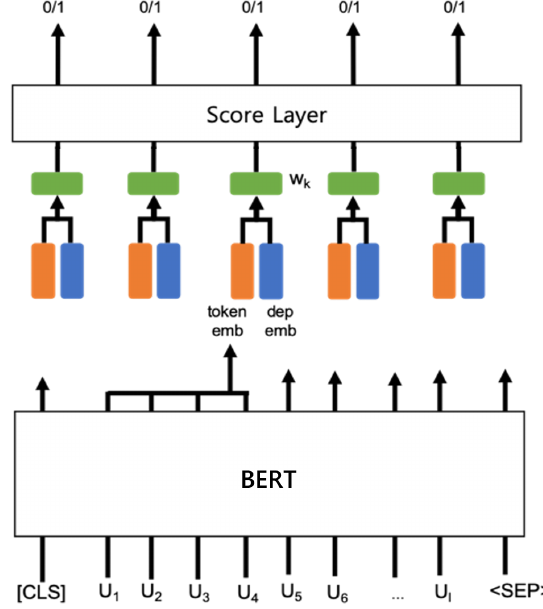
Figure 1. Baseline model representing sentence